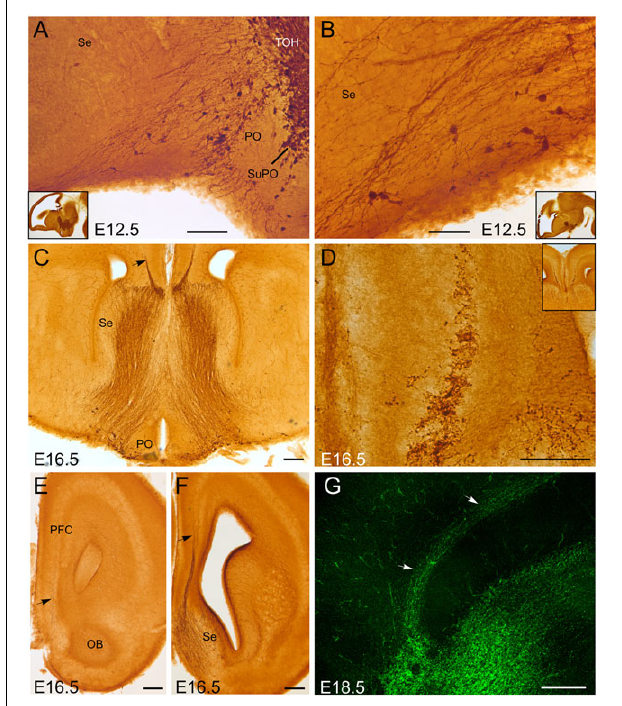
FIGURE 2 | GFP immunoreactive cells and fibers in the embryonic septum and adjacent cortex. Images of brain sections of Otp-eGFP embryonic mice (E12.5 to E18.5), showing GFP immunoreactive cells and fibers in the preoptic area and septum (A–C) , and a fascicle of labeled fiber with intermingled cell bodies traversing the septo-cortical border [arrow in panel (C) and detail in panel (D) ]. Labeled fibers and cells entering the cortex through this pathway are evident before the formation of corpus callosum and, later, at precallosal levels; from here they continue caudalwards as part of the cingulate bundle [arrows in panel (G) ]. Panels (A,B,G) are sagittal sections; [panel (G) is fluorescent]; panel (C) is an oblique-horizontal section; [panel (D) is a detail of panel (C) ]; panels (E,F) are frontal sections. Note the continuity of labeled fibers and cells of the septopreoptic region with those in the subpreoptic area (SuPO) of the TOH (A) . See text and abbreviation list for more details. Scale bar: panels (A,D) = 100 µ m. panel (B) = 50 µ m. panels (C,E–G) = 200 µ